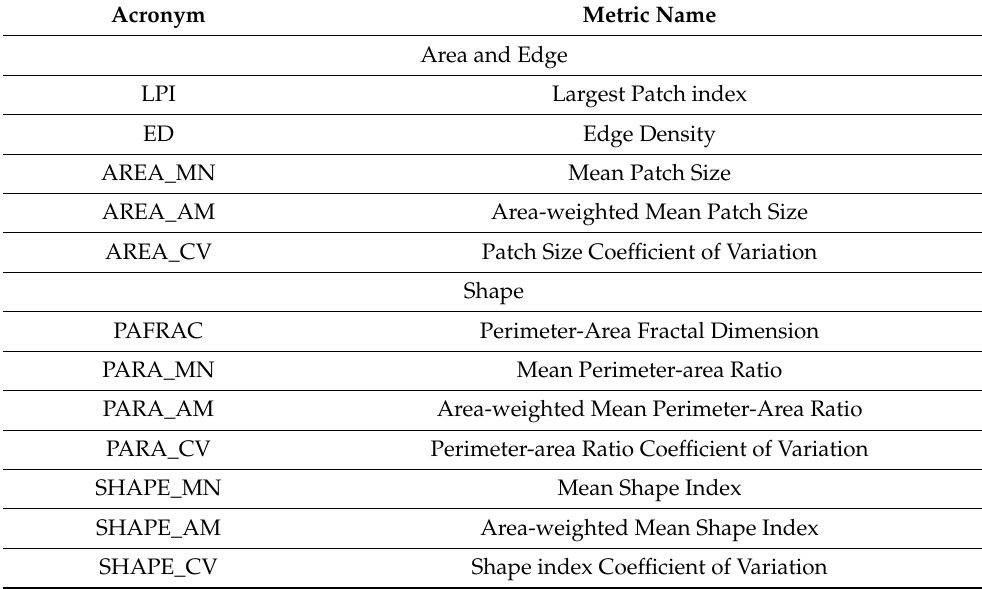
Table A1. Landscape level metrics used in this study (based on FragStats